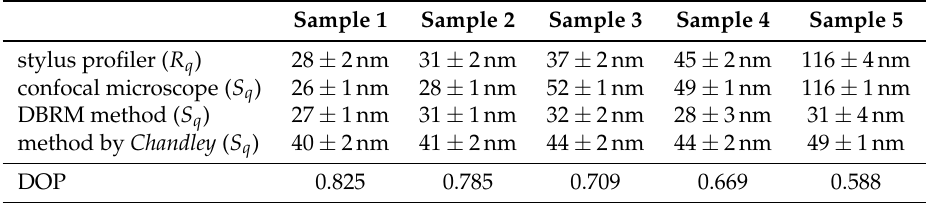
Table 1. Experimental results for five samples measured by different methods, namely the stylus profiler, the confocal microscope, the DBRM technique and Chandley’s method, respectively. The uncertainties of the techniques and the degrees of polarization (DOP) are also